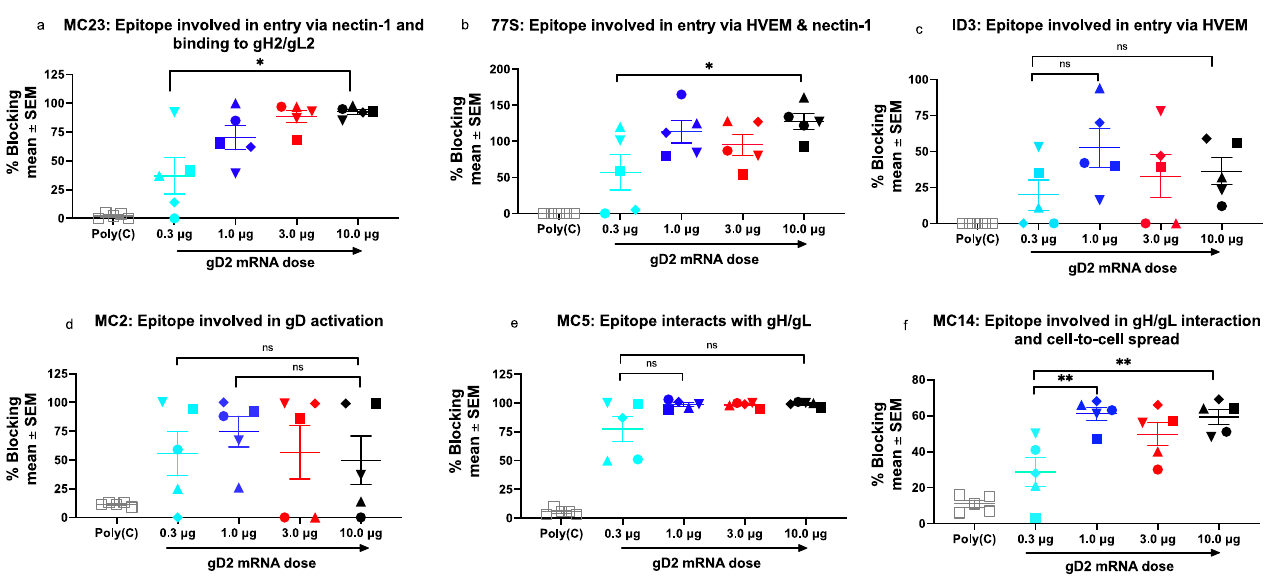
Figure 3. gD2 mRNA-LNP produces antibodies to important functional epitopes. Antibody responses were measured to six functional gD2 epitopes identified by MAb ( a ) MC23, ( b ) 77S, ( c ) ID3, ( d ) MC2, ( e ) MC5, and ( f ) MC14. Sera from five mice were evaluated per vaccine dose. The shape of the symbol identifies individual mice in the gD2 mRNA groups; for example, the animal indicated by a rectangle in ( a ) is also denoted by a rectangle in ( b – f ). We calculated p values comparing the highest dose (10 μ g) with the lowest dose (0.3 μ g), and the dose producing the highest antibody titer with the lowest antibody titer. p values were performed using the two-tailed Mann–Whitney test or ordinary one-way ANOVA with Sidak’s correction when multiple comparisons were performed. * p < 0.05; ** p < 0.01; ns, not